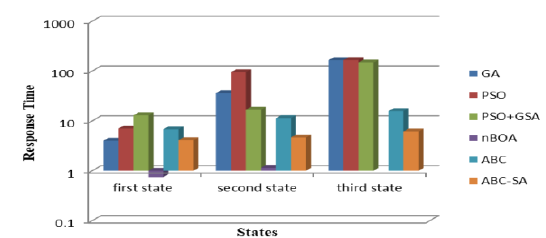
Figure 8. Comparison of response time for the N-Queen problem.